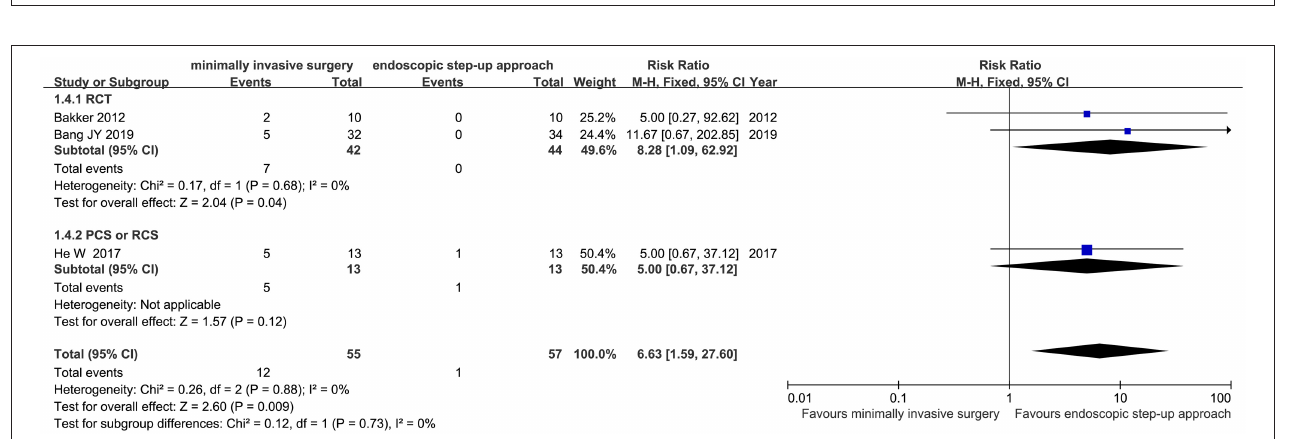
FIGURE 6 | Forest plots for the incidence of intestinal fistula after minimally invasive surgery and endoscopic step-up approach. M-H, Mantel–Haenszel test; Fixed, a fixed effects model; CI, confidence intervals.